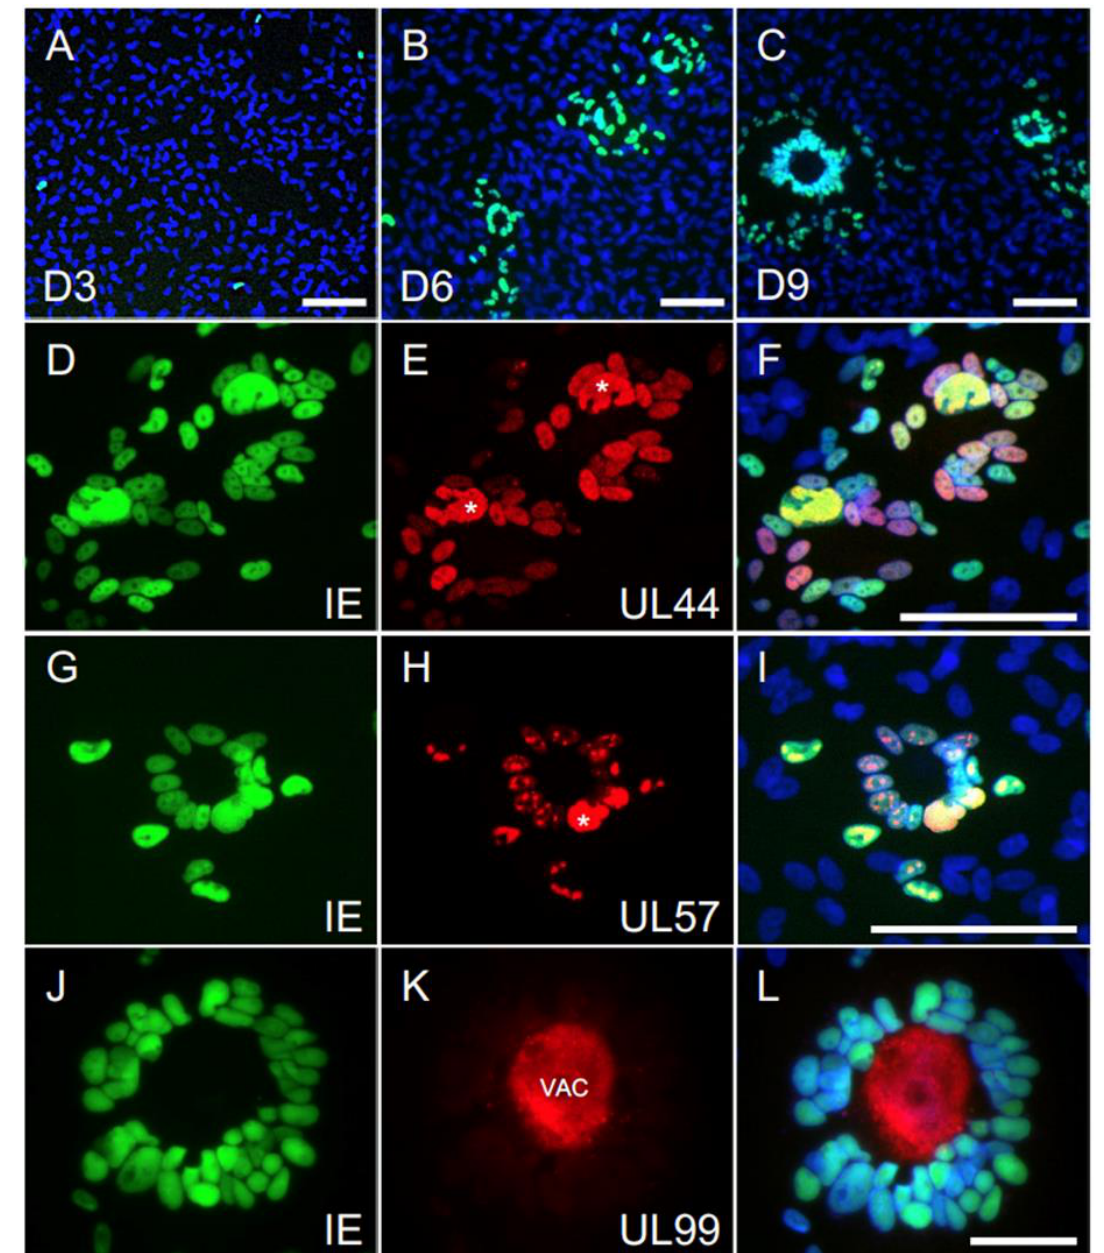
Figure 6. Viral antigen expression in syncytia. ARPE-19 cells were infected at an MOI of 0.01 pfu / cell with the SE2 or CE2 stocks prior to staining for IE, UL44, UL57 or UL99. ( A – C ) Micrographs of infected populations stained for IE (green) and with Hoechst 33342 (blue) at days 3, 6 and 9 pi (D3, D6 and D9). ( D – F ) Micrographs of infected populations stained for IE (green) and for UL44 (red) at day 6 pi. ( G – I ) Micrographs of infected populations stained for IE (green) and for UL57 (red) at day 6 pi. ( J – L ) Micrographs of infected populations stained for IE (green) and for UL99 (red) at day 9 pi. Merged images ( F , I , L ) also show nuclear staining with Hoechst 33342. Asterisks mark the viral DNA replication compartments. VAC = virion assembly compartment. White bars = 100 µ